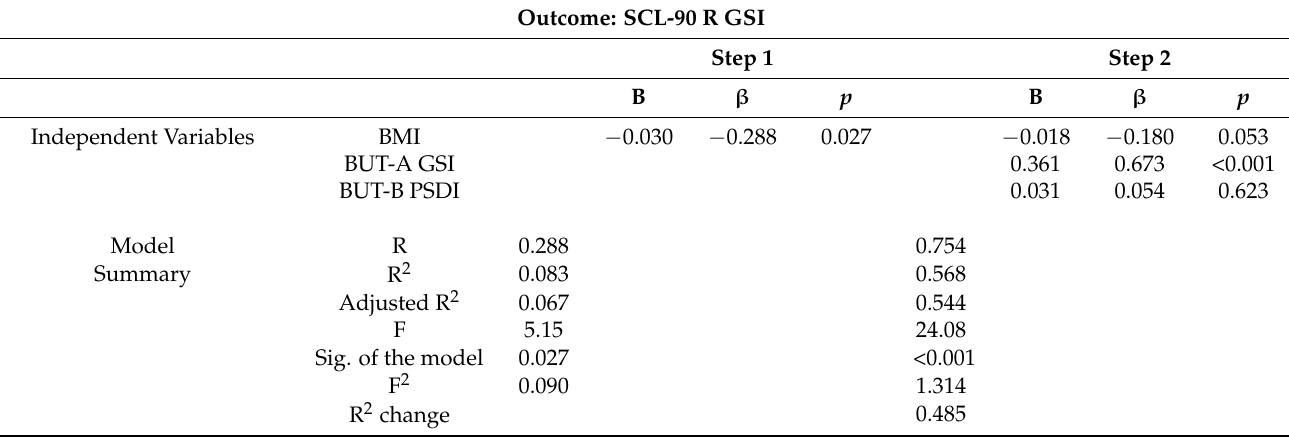
Table 3. First hierarchical regression models including two steps, with BMI as predictor in first step; BMI, BUT-A GSI, and BUT-B PSDI as predictors of SCL-90 GSI in second step. Outcome: SCL-90 R GSI Step